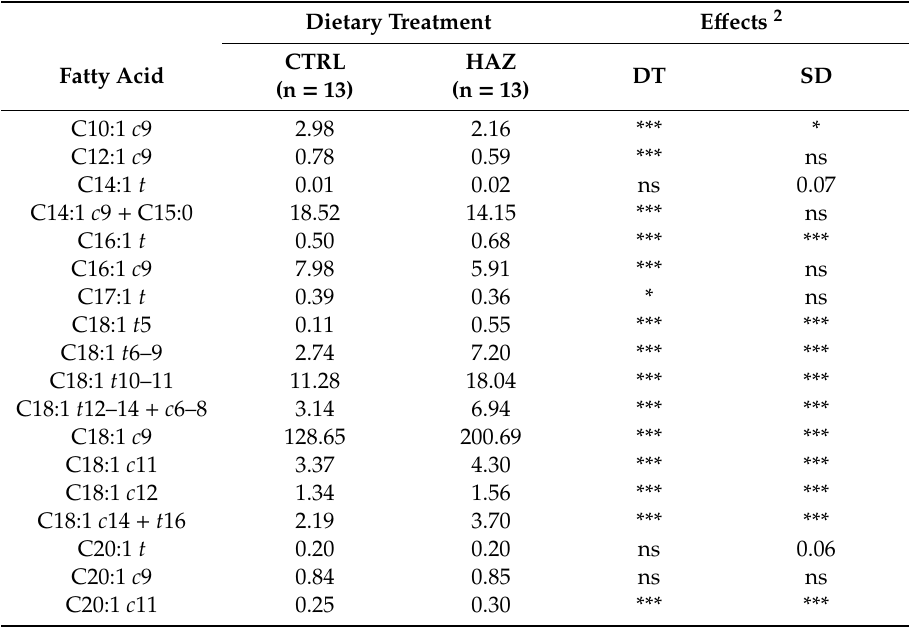
Table 5. Monounsaturated fatty acids (g / kg fat) in milk of cows fed the control (CTRL) and hazelnut skin (HAZ) diets 1 . Dietary Treatment E ff ects